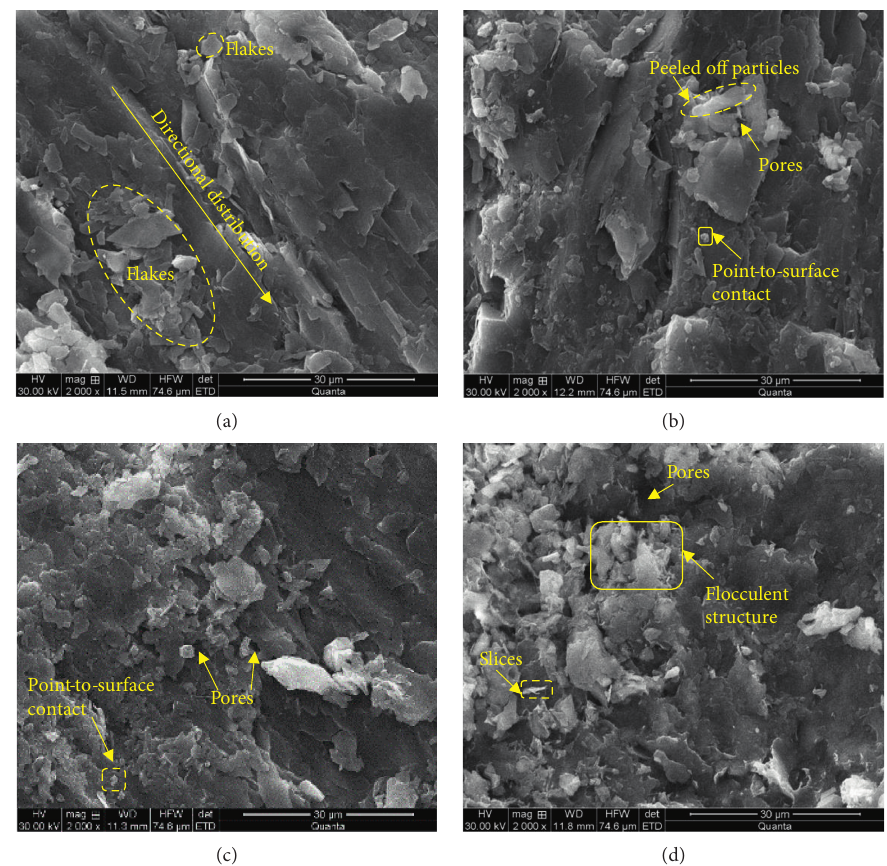
Figure 11: Microstructure of shale under various water immersion times: (a) 0 days; (b) 2 days; (c) 20 days; (d) 50